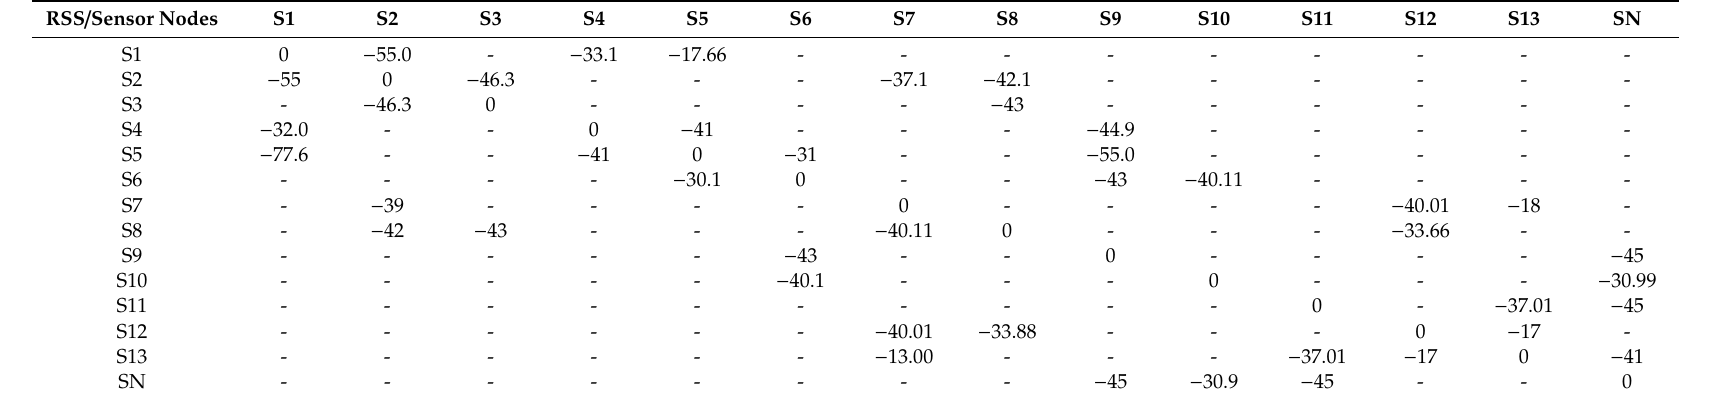
Table 3. RSSI values of nearby nodes based on